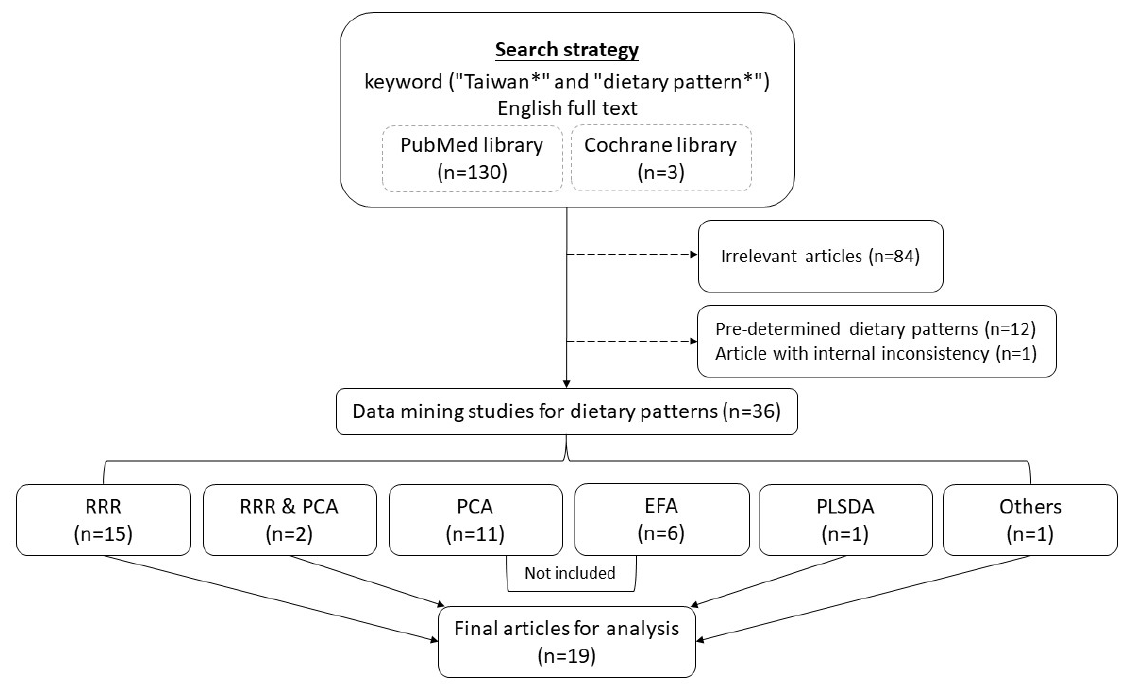
Figure 1. Flow chart of literature search. EFA, exploratory factor analysis; PCA, principal component analysis; PLSDA, partial least square discriminant analysis; RRR, reduced rank regression. Table 1. Description of the included data mining dietary pattern